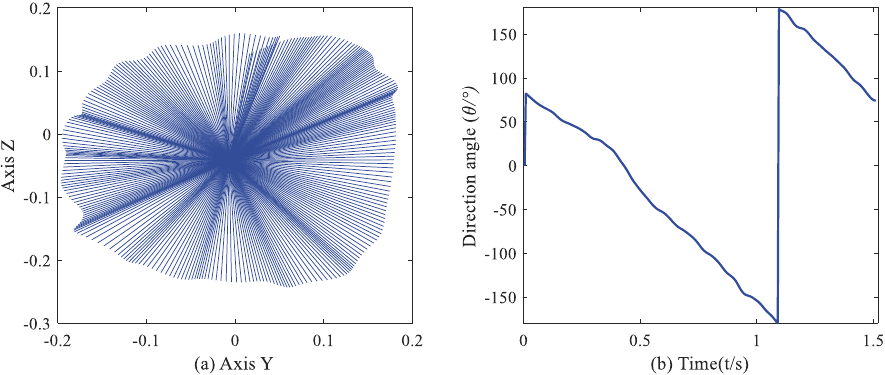
Figure 2. ( a ) Acceleration vector in YZ – plane (in the earth frame). ( b ) Direction angle of acceleration vector varying with time.